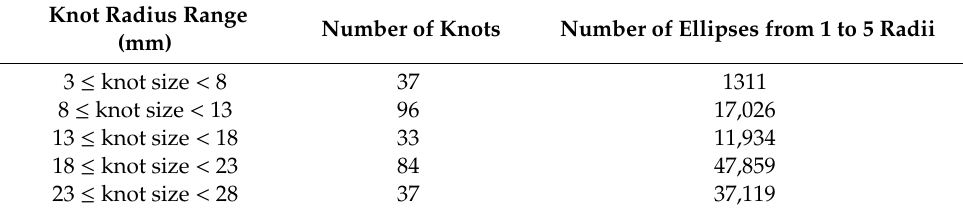
Table 3. Measured information of the first log branches.